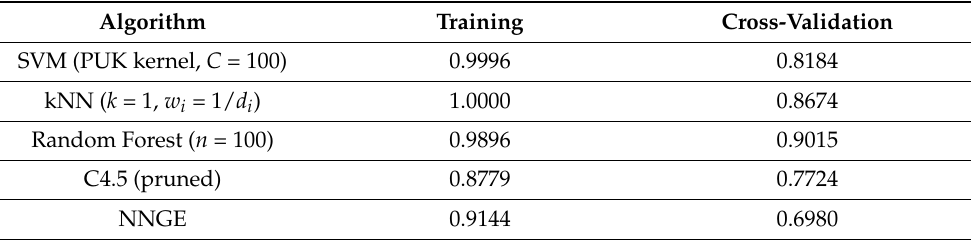
Table 7. Results of using classification algorithms to predict the RNFL parameter based on glaucoma risk